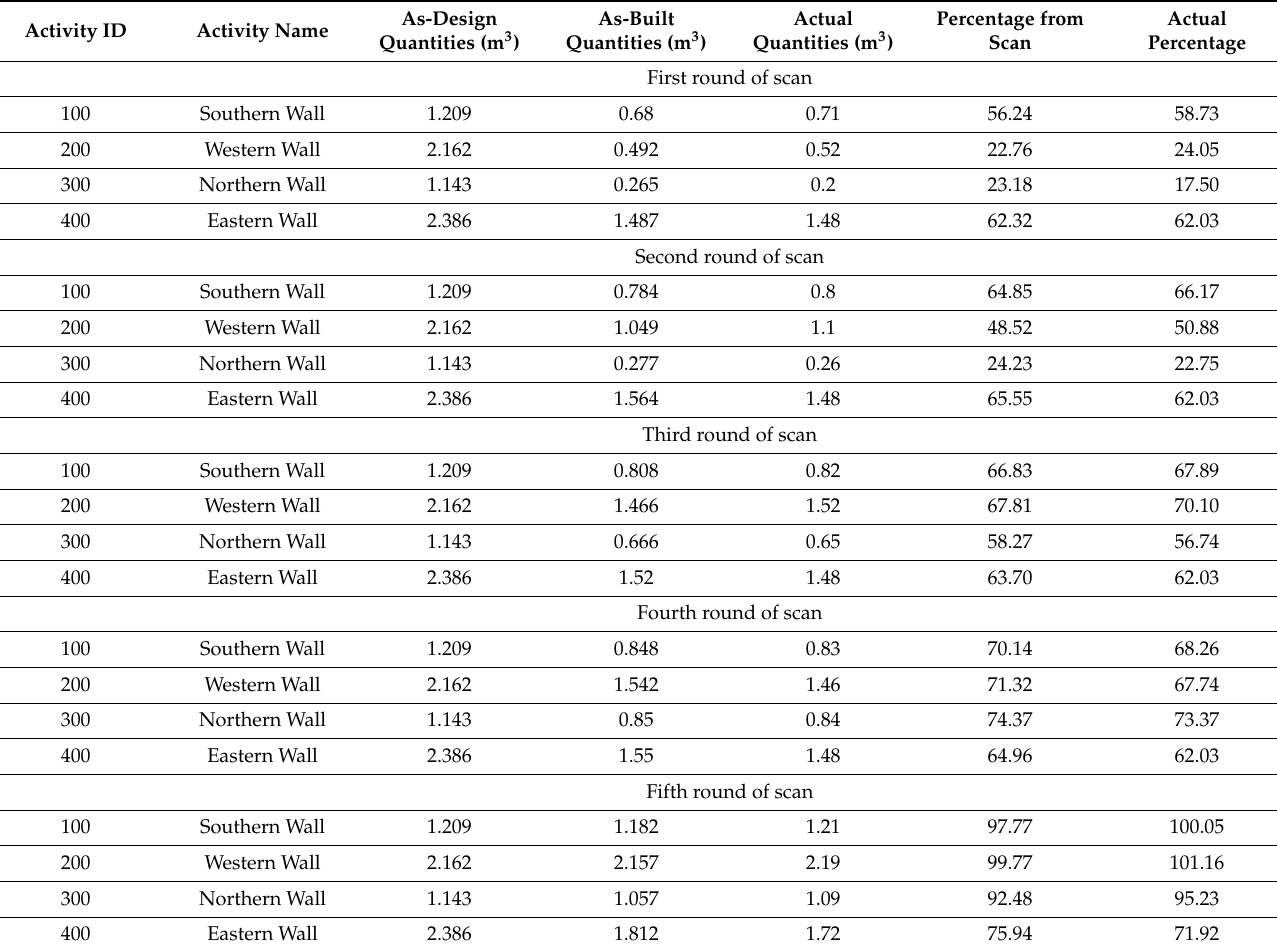
Table 1. Construction progress calculation.